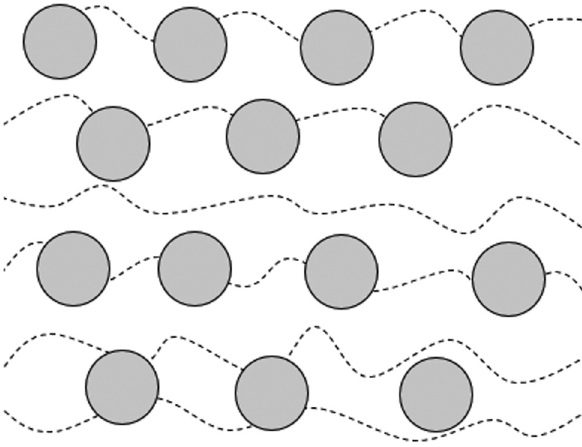
Figure 2: Uniform dispersion of cement